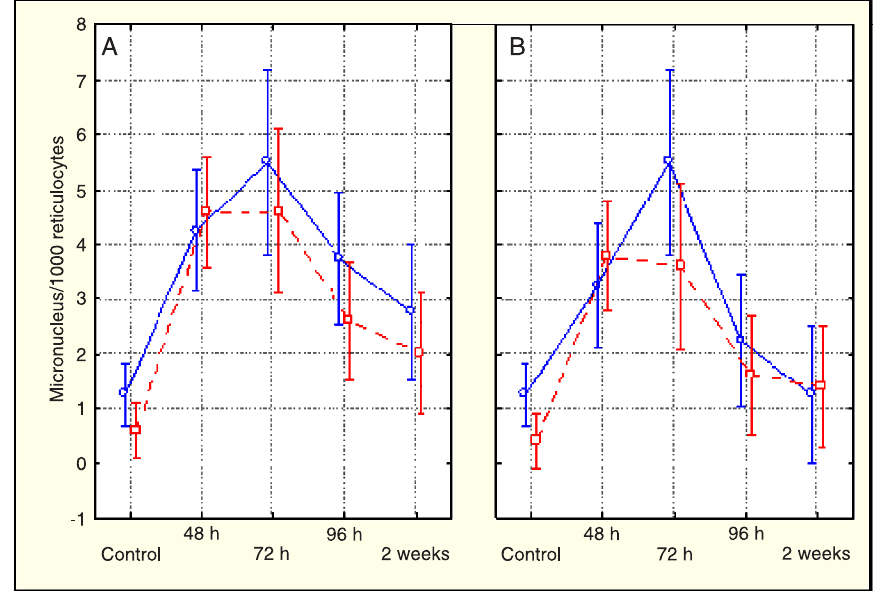
Figure 3. Micronucleus (MN) frequency in A , 3- and B , 12-week-old male (blue full line) and female (red dashed line) mice exposed to 0.5 µg/kg diethylstilbestrol. For each dose, age and sex, 5 animals were analyzed. Micronucleus frequency is presented per 1000 reticulocytes. Vertical bars indicate 95% confidence intervals. ANOVA for repeated measurements was used to compare responses at each sampling